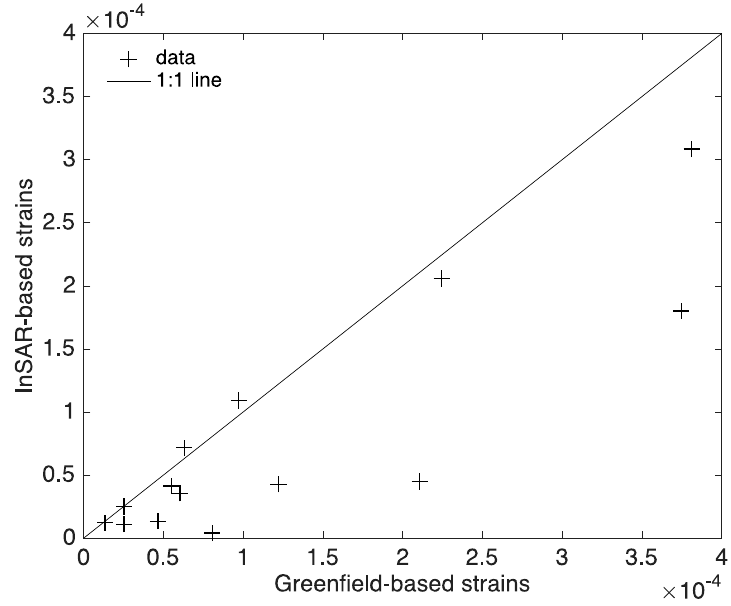
Figure 6. Greenfield-based vs . InSAR-based building strains.